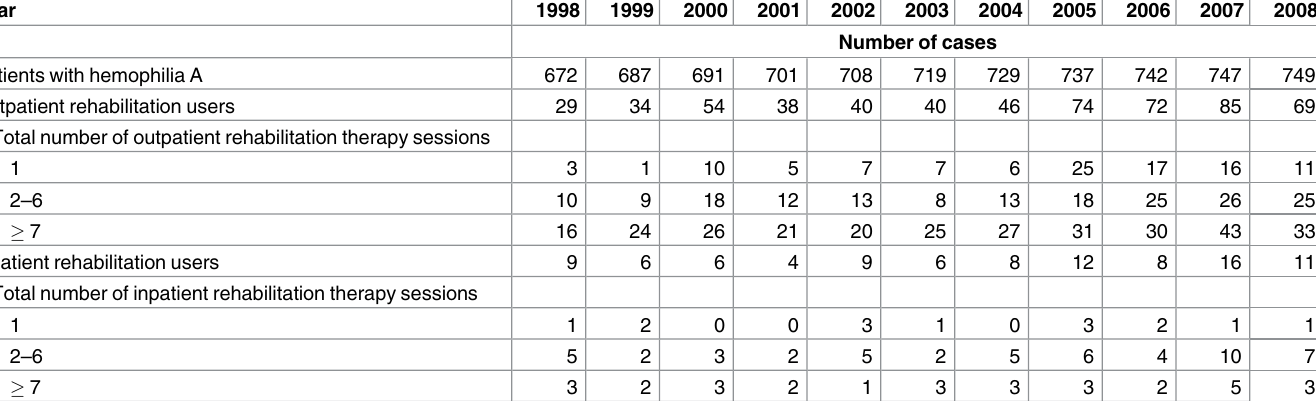
Table 3. Distributions of total number of hemophilia A cases and number of rehabilitation users in terms of the number of rehabilitation therapy sessions received.